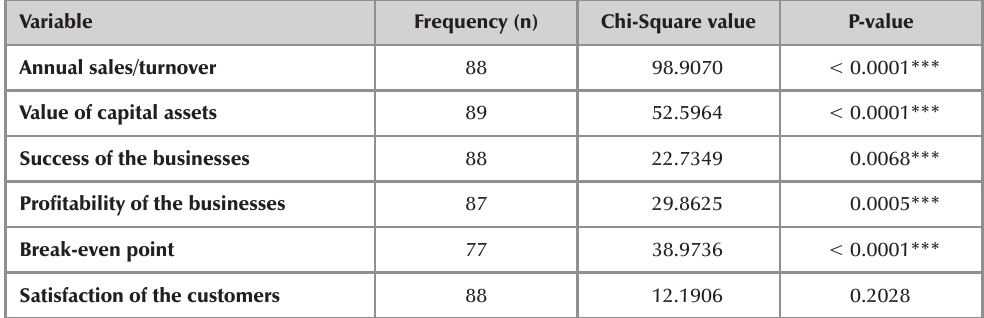
Chi-square test: Comparison between the before and after measurement of the experimental group regarding business performance